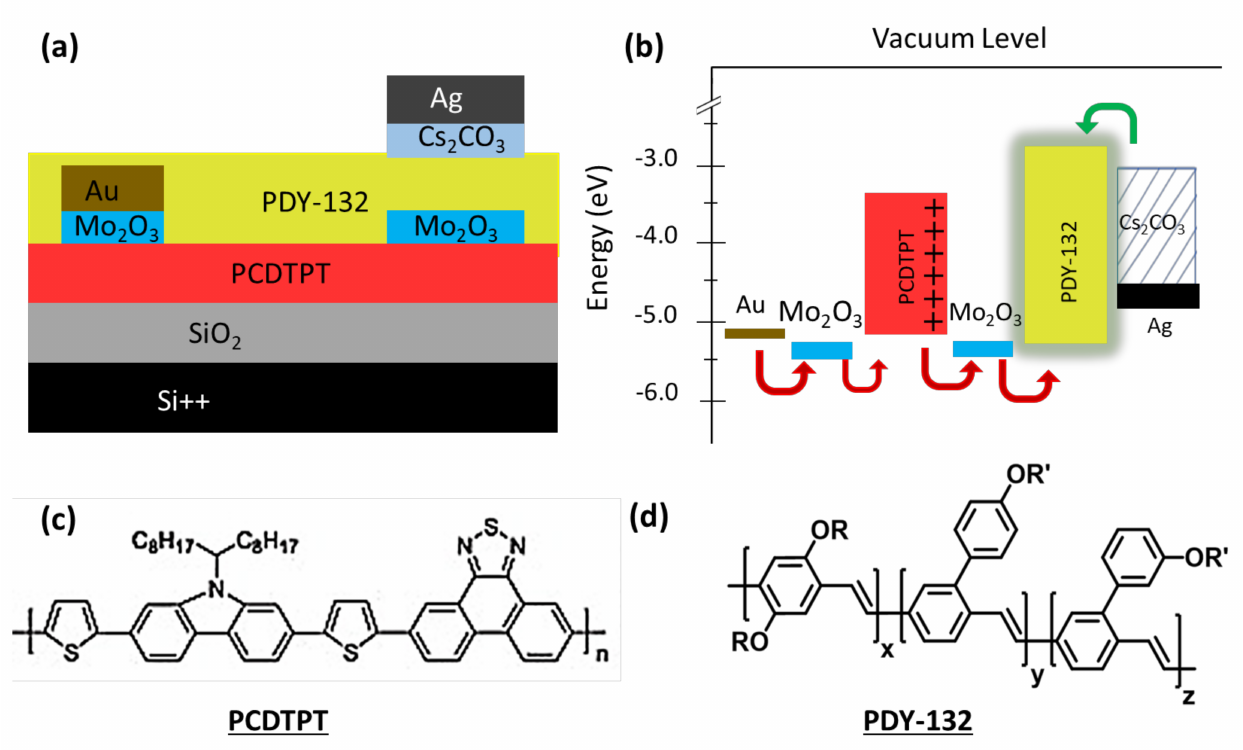
Figure 1. ( a ) Device structure with Mo 2 O 3 and Cs 2 CO 3 interlayers and ( b ) energy diagram of active materials and injection layers. Molecular structures of polymers ( c ) PCDTPT and ( d ) PDY–132 (Super